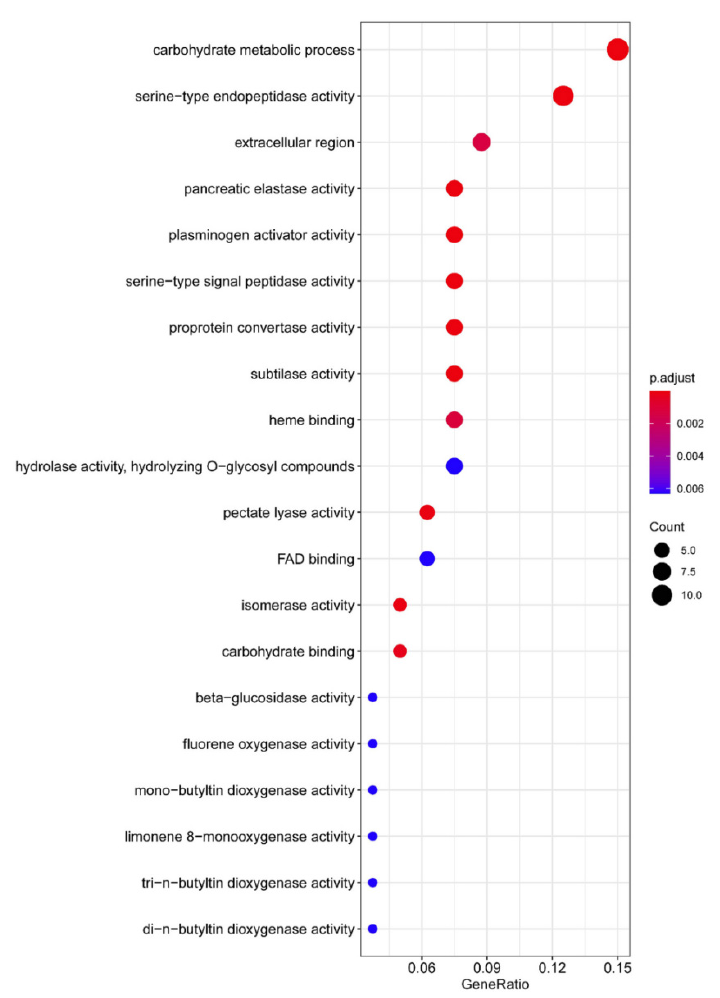
Figure 5. Gene Ontology (GO) enrichment analysis of the genes correlated with PsCZF3 . Color scale represents the Benjamini–Hochberg adjusted p -values, and the size of circles indicates gene numbers. X-axis, GeneRatio, amount of DEGs enriched in the pathway/amount of all genes in annotation gene set; Y -axis, GO term ( p < 0.05).